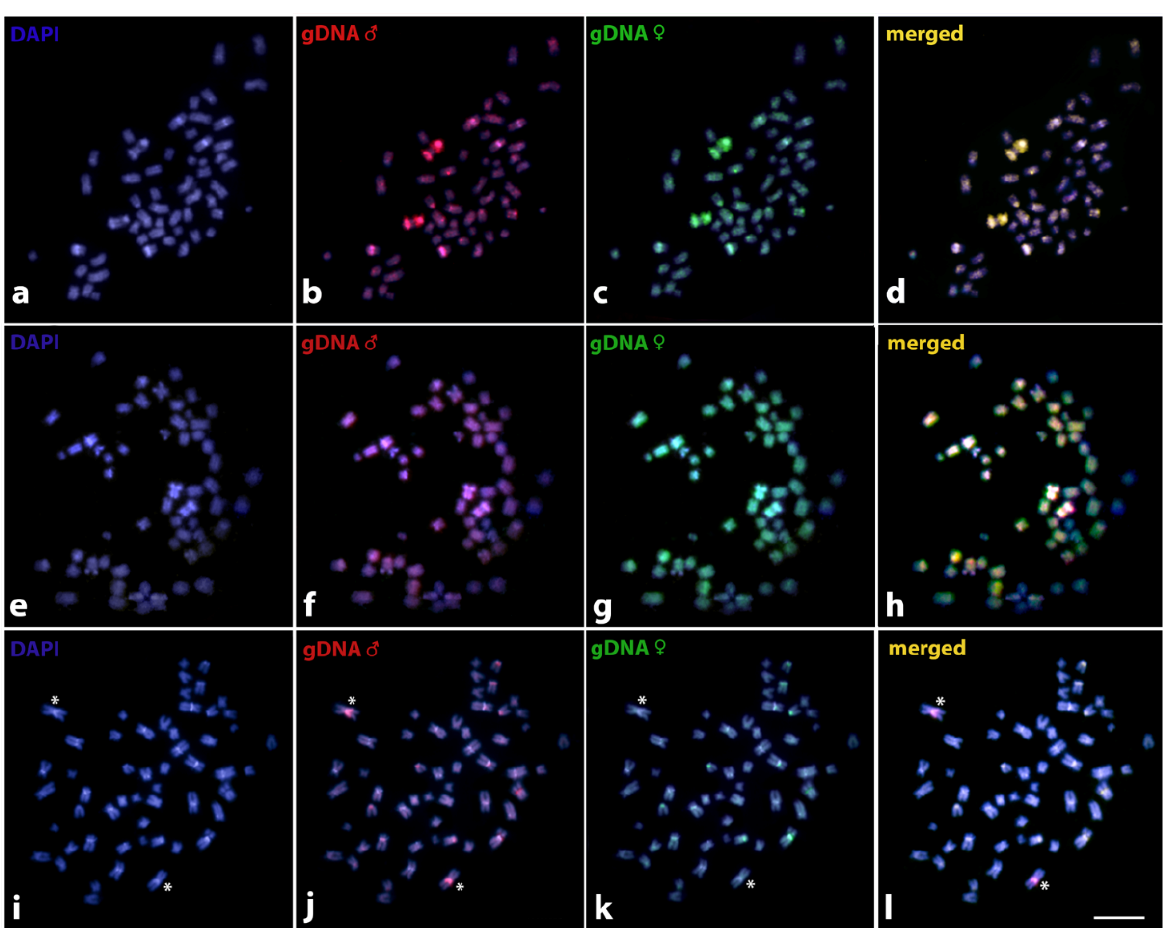
Figure 5. Mitotic chromosome spreads of Harttia males after intraspecific (male-to-female) CGH procedure. Harttia dissidens ( a – d ), H. guianensis ( e – h ), and Harttia sp. 3. ( i – l ). First column ( a , e , i ): DAPI images (blue); second column ( b , f , j ): hybridization patterns of male gDNA probes; third column ( c , g , k ): hybridization patterns of female gDNA probes; fourth column ( d , h , l ): merged images of both genomic probes and DAPI counterstaining. Regions with excessive hybridization of both genomic probes are yellow (i.e., combination of green and red). Asterisks highlight the regions with preferential accumulation of male gDNA probe when compared to patterns of a female gDNA probe hybridization. Scale bar = 10 µm.